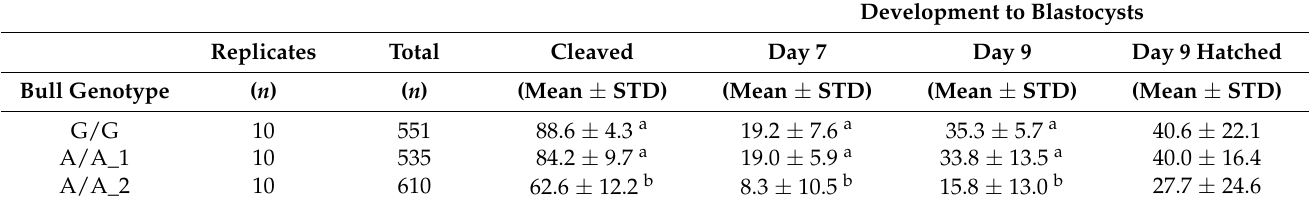
Table 2. Effect of sire genotype on in vitro developmental rates (%) after in vitro fertilization.